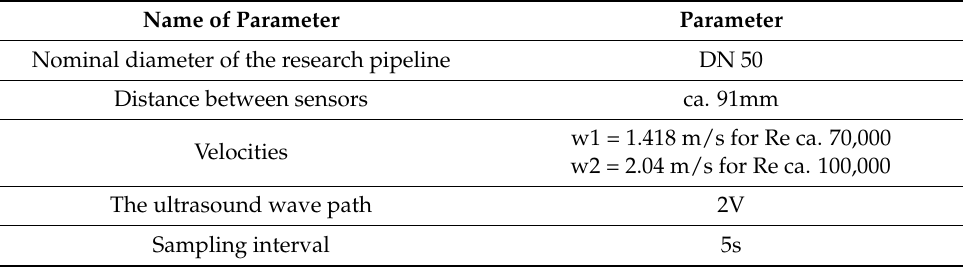
Table 2. Detailed specification of measurement